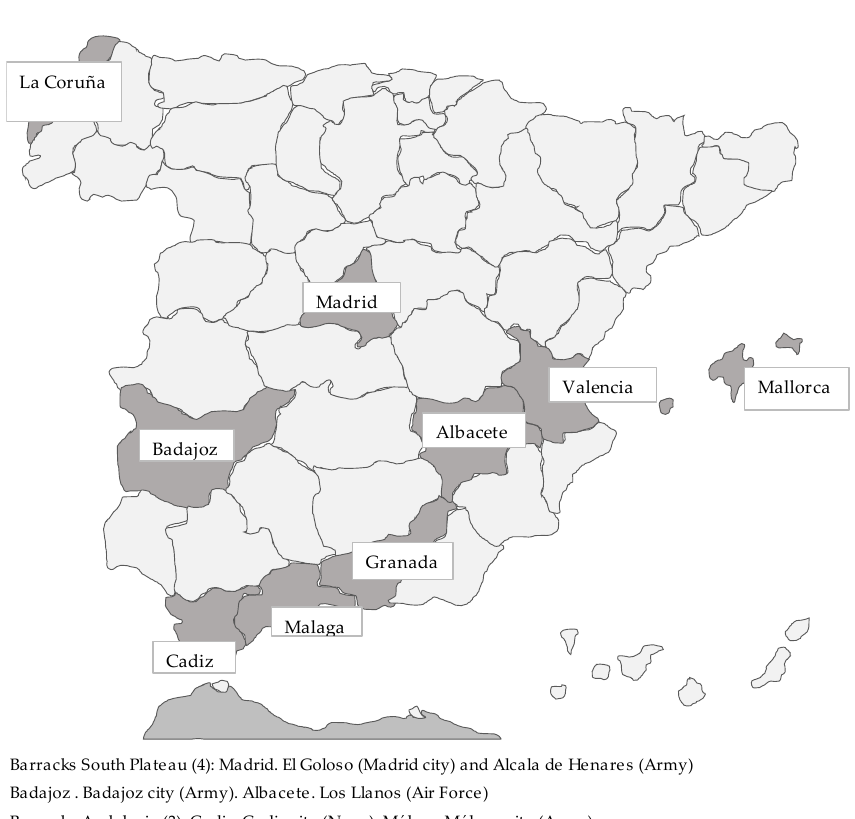
Figure 1. Locations of the military units surveyed.